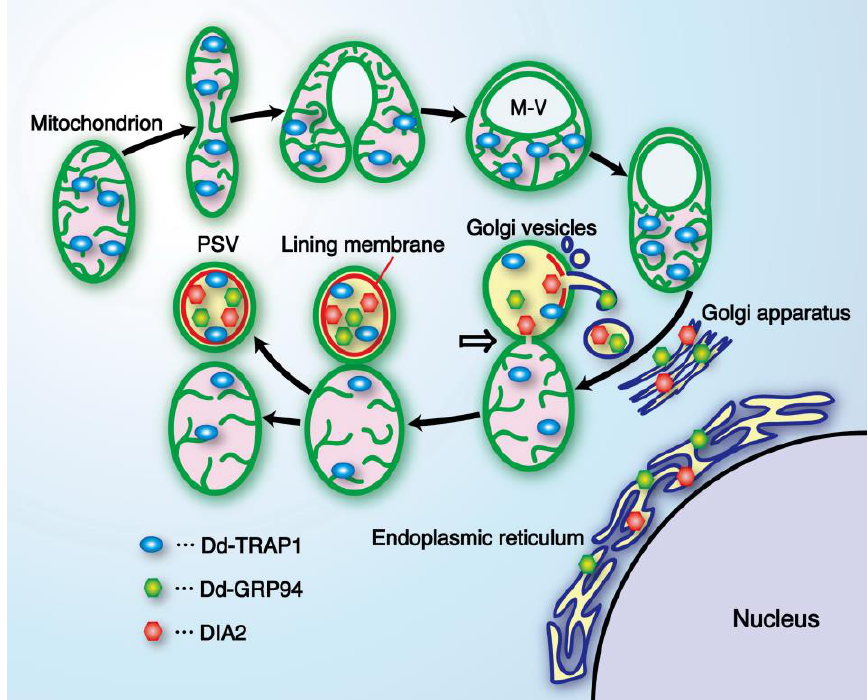
(Slightly modified from Maeda